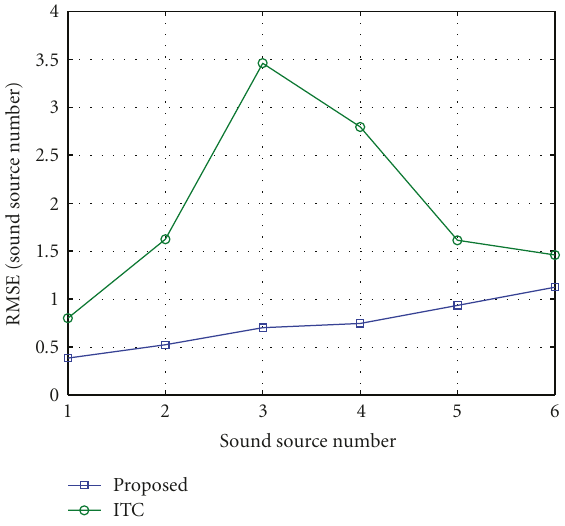
Figure 9: Sound source number estimation